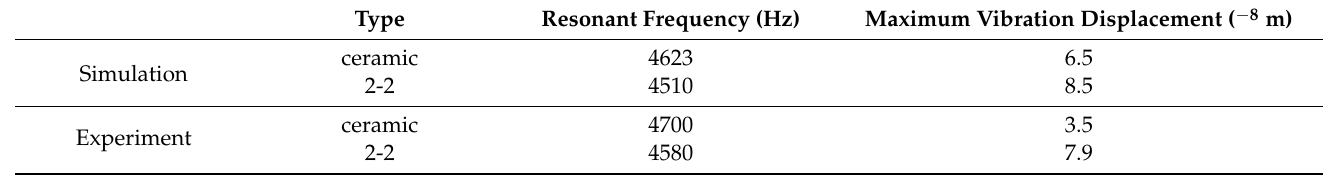
Figure 11. Vibration mode diagram of double-laminated elements. ( a ) 1/2 vibration period of the ceramic double-laminated element; ( b ) 2/2 vibration period of the ceramic double-laminated element; ( c ) 1/2 vibration period of the piezoelectric composite double-laminated element; ( d ) 2/2 vibration period of the piezoelectric composite double-laminated element. Table 2. Comparison between experimental test performance and simulation performance.